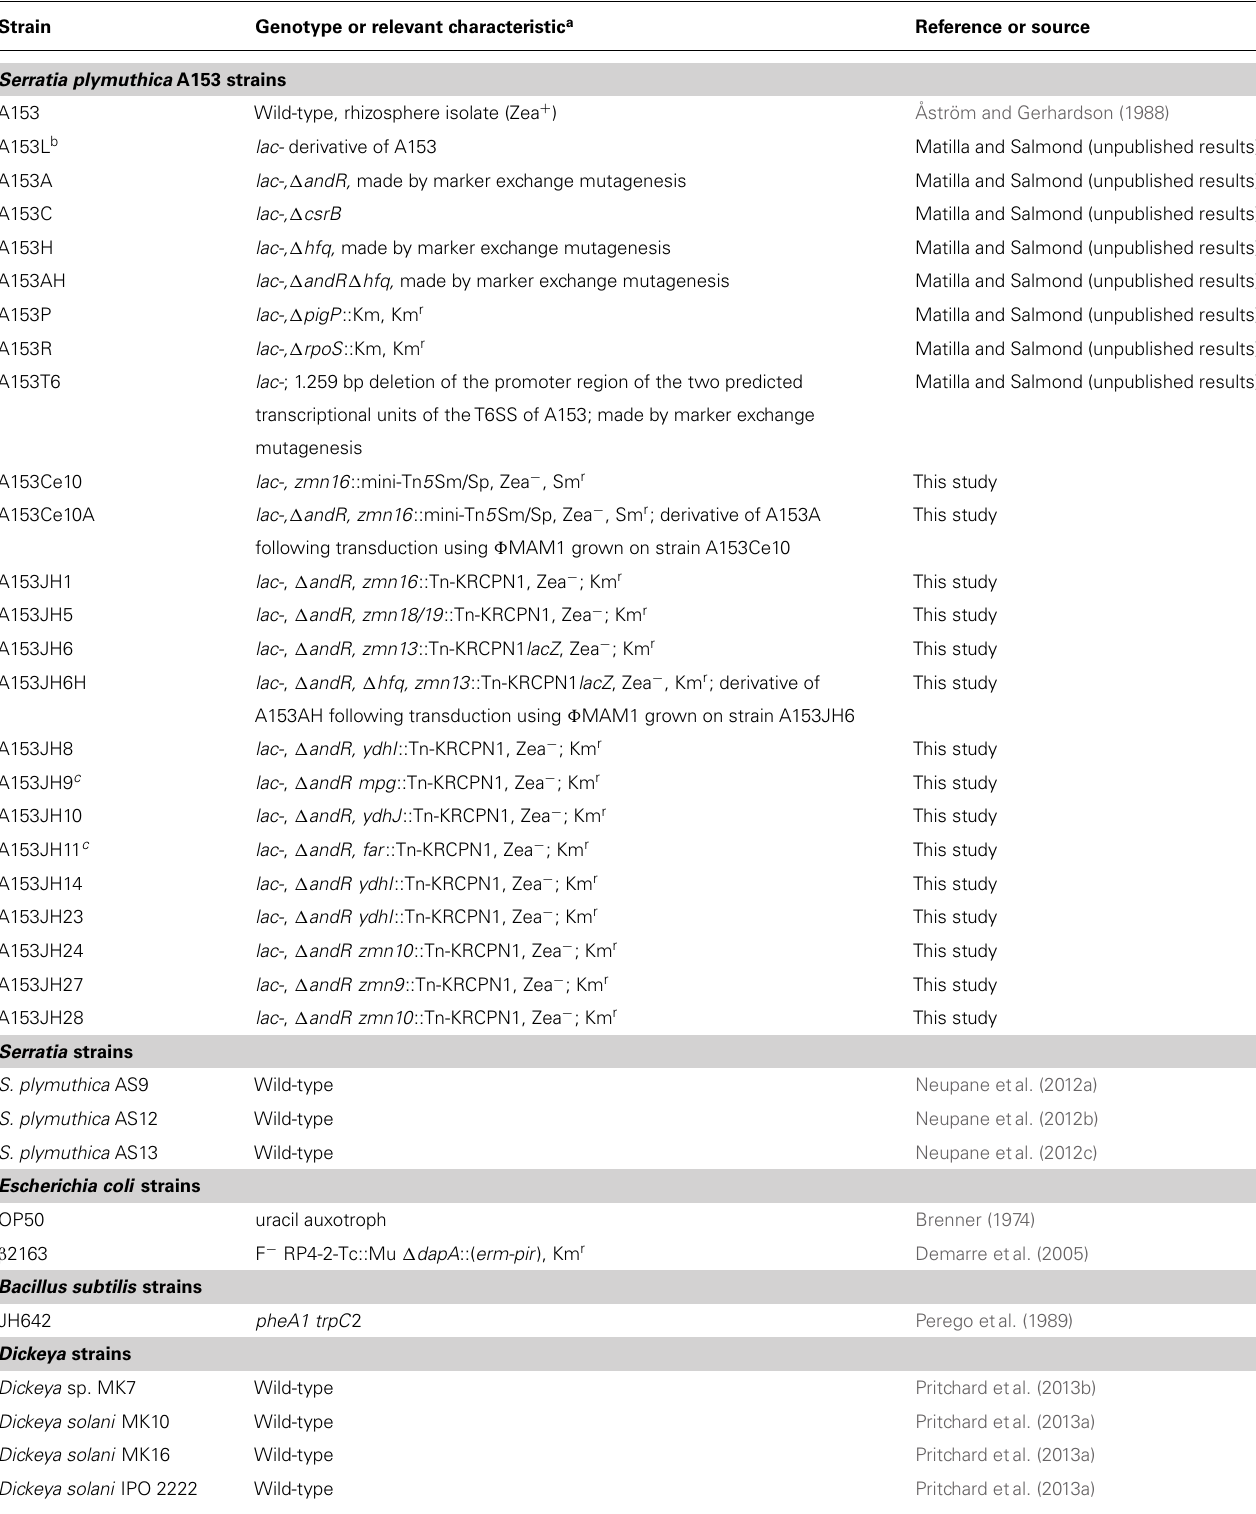
Table 1 | Strains, phages, and plasmids used in this study. Strain Genotype or relevant characteristic a Reference or source Serratia plymuthica A153 strains A153 Wild-type, rhizosphere isolate (Zea + ) Åström and Gerhardson (1988) A153L b lac- derivative of A153 Matilla and Salmond (unpublished results)